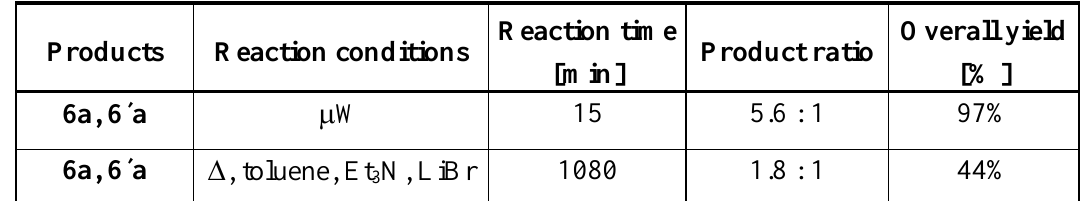
Table 2 . Comparison of the reaction yields of products 6a and 6’a under different reaction